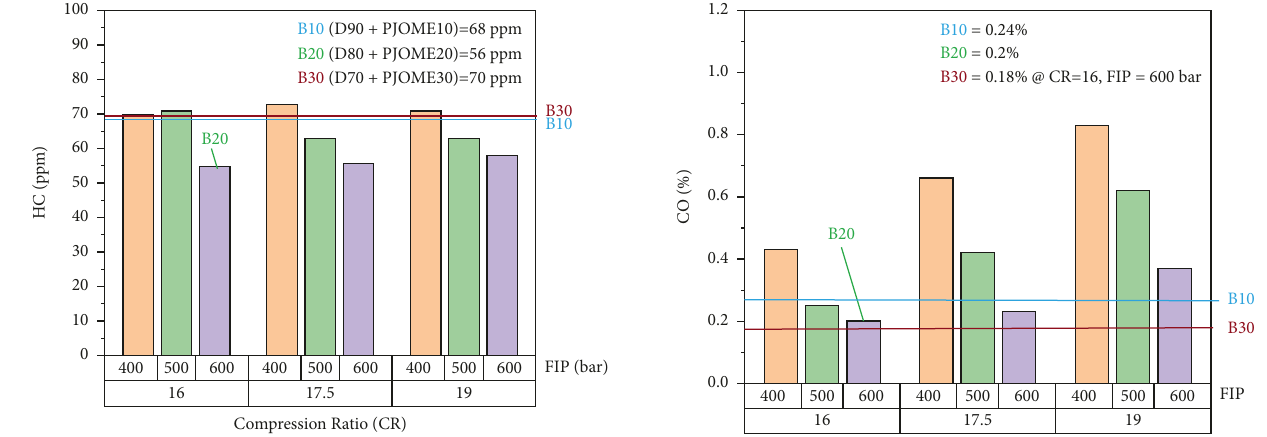
Figure 8: HC emission for B20 blend at different FIPs and